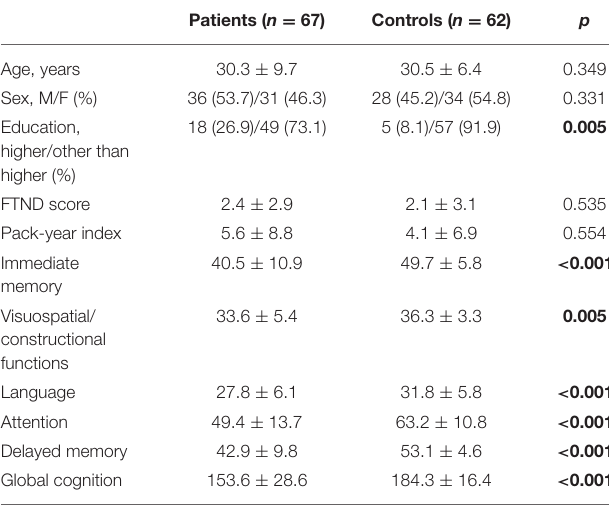
TABLE 1 | General characteristics of patients and